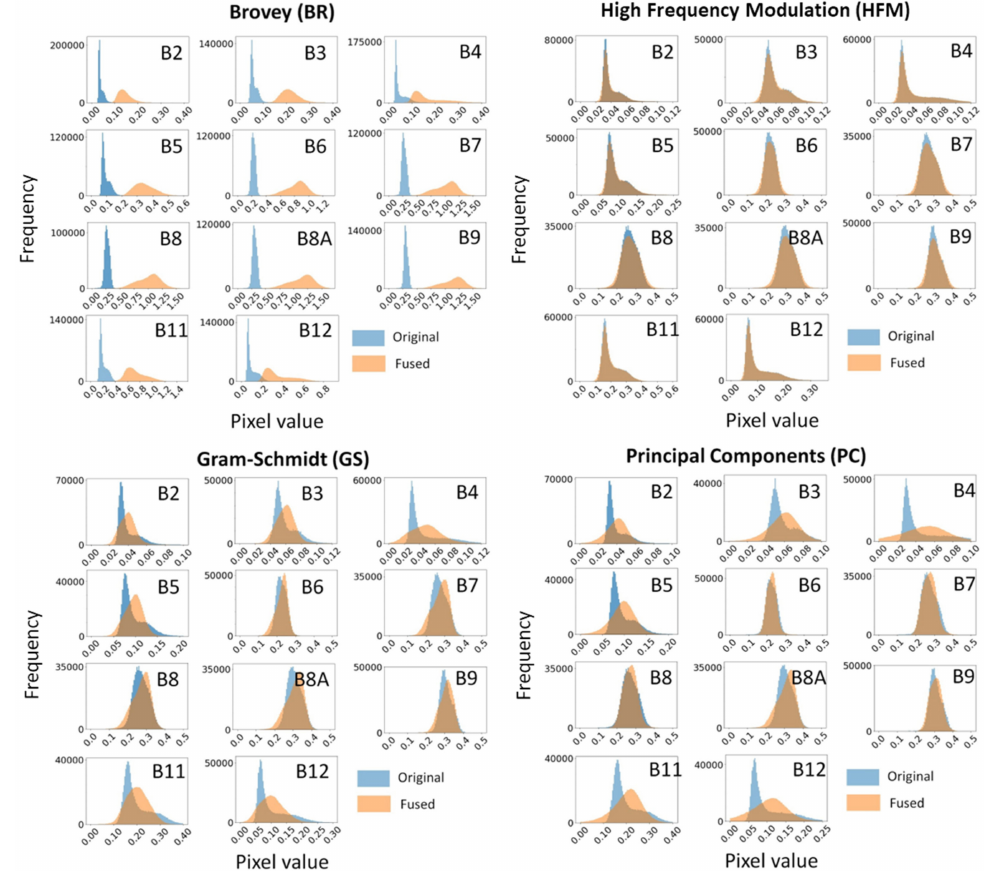
Figure 4. Histogram by bands of the pixel values of the images fused by the different methods evaluated vs. Sentinel-2 optical image. Values in orange correspond to the fused image; values in blue correspond to the Sentinel-2 optical